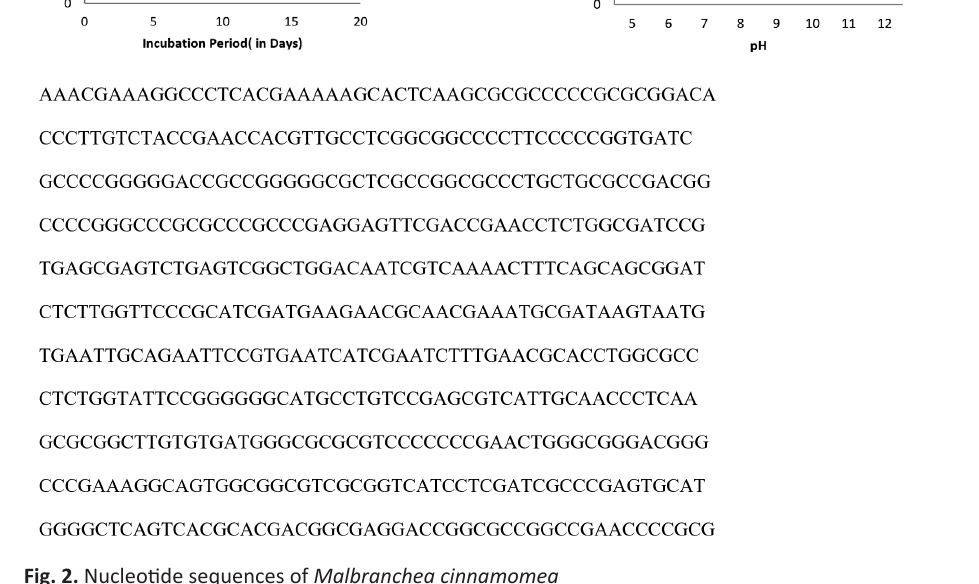
Fig. 2. Nucleotide sequences of Malbranchea